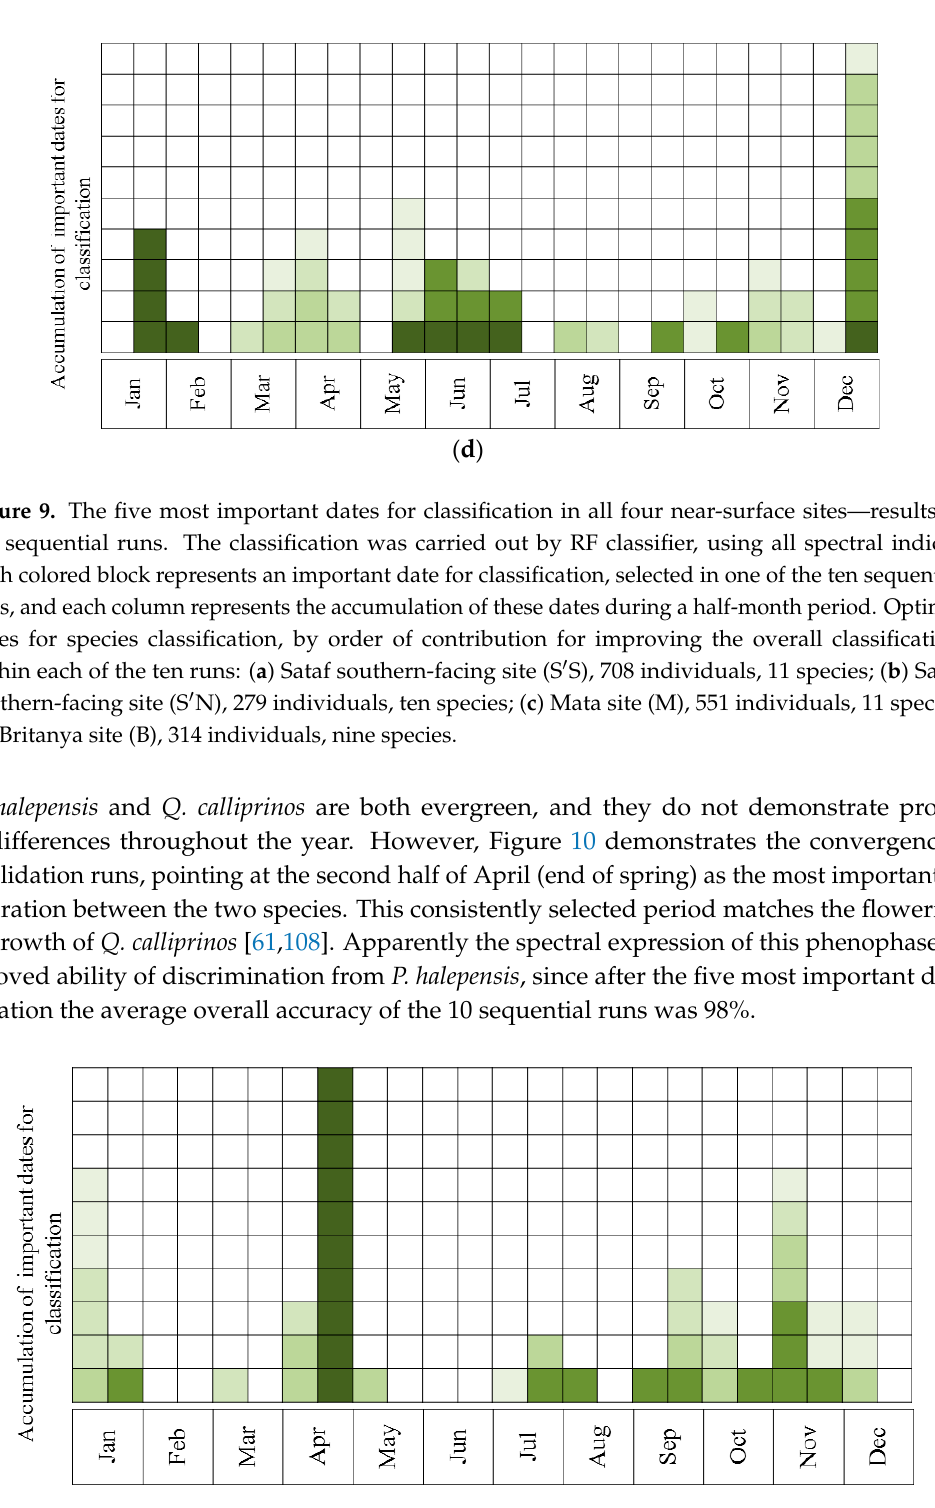
Figure 10. The five most important dates for discrimination between Pinus halepensis (N = 26) and Quercus calliprinos (N = 56) in the Sataf southern-facing site (S ′ S) of near-surface observations—results of ten sequential runs. The classification was carried out by RF classifier, using all spectral indices. Each colored block represents an important date for classification, selected in one of the ten sequential runs, and each column represents the accumulation of these dates during a half-month period. See legend in Figure 9a–d for the order of contribution.